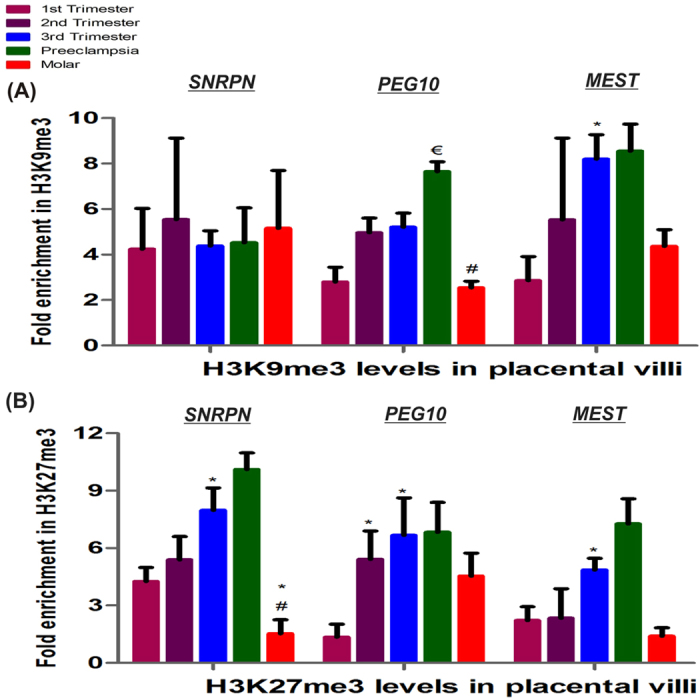
Quantification of histone trimethylation at DMRs of imprinting genes among placental villous groups.Fold enrichment relative to non-specific IgG acting as negative control and normalized with input DNA in (A) H3K9me3 and (B) H3K27me3. The data is presented as mean of the observed fold change ± SEM; n = 4 per group. *p < 0.05 vs 1st trimester, #p < 0.05 vs 2nd trimester, €p < 0.05 vs 3rd trimester.